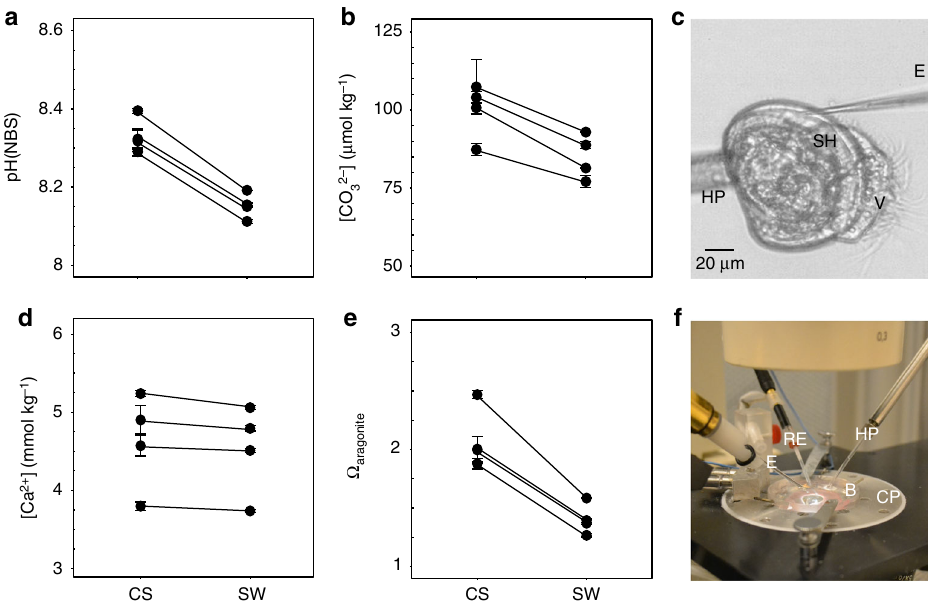
Fig. 3 Carbonate chemistry parameters in the calci fi cation space of PD I larvae from Exp 3. a pH NBS . b [CO 3 2 − ]. c Image of larva attached to a holding pipette (HP) with the tip of the measuring electrode (E) visible at the site of calci fi cation (CS), below the shell (SH), V = velum. d [Ca 2+ ]. e Ω arag . f Setup for microelectrode measurements showing inverted microscope, the electrode, holding pipette, water bath (B), reference electrode (RE) and cooling plate (CP). Plotted data are the mean ± s.d. from N = 4 fertilizations and 5 larvae for each treatment and